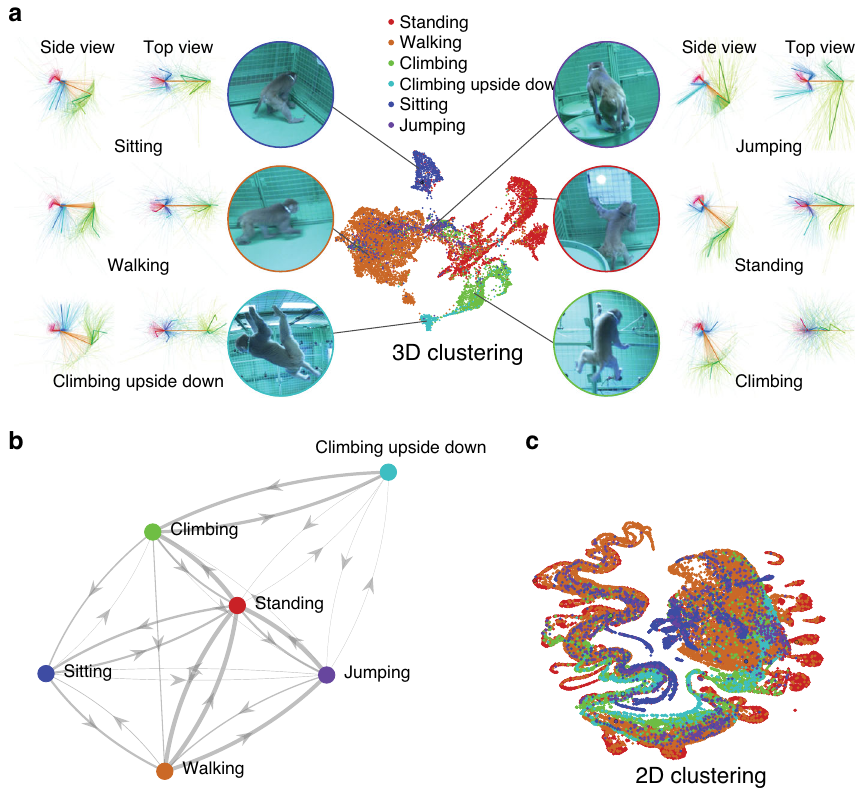
Fig. 6 Semantic action detection. We use the 3D pose representation to recognize semantic actions (standing, walking, climbing, climbing supine, sitting, and jumping). a The poses are clustered by using UMAP. Each cluster that is represented by 3D poses (side and top views) is highly correlated with the semantic actions. b With the clusters, we recognize actions in a new testing sequence using the k nearest neighbor search and visualize the transitions among the semantic actions. c In contrast, the 2D representation provides the clusters that are driven by the pose and viewpoint. For instance, while the 3D representation of walking is one continuous cluster, the 2D representation is broken apart into discrete groupings of repeated poses at different spatial